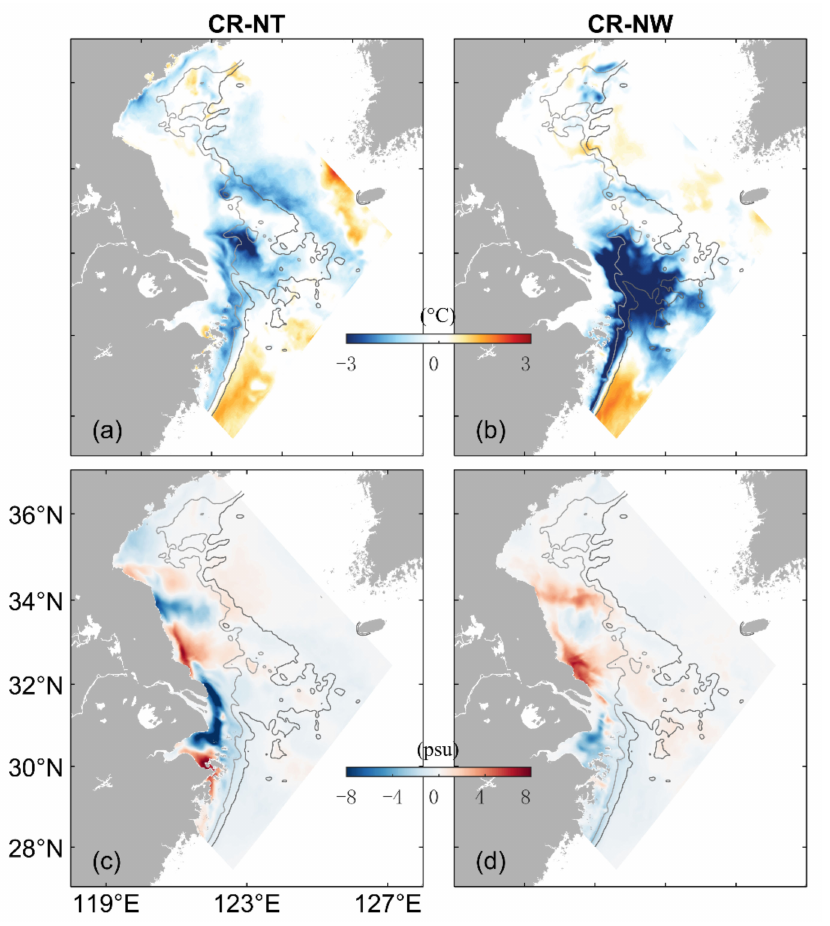
Figure 13. Same as Figure 12 except for the near bottom temperature ( a , b ) and near bottom salinity ( c , d ) in February